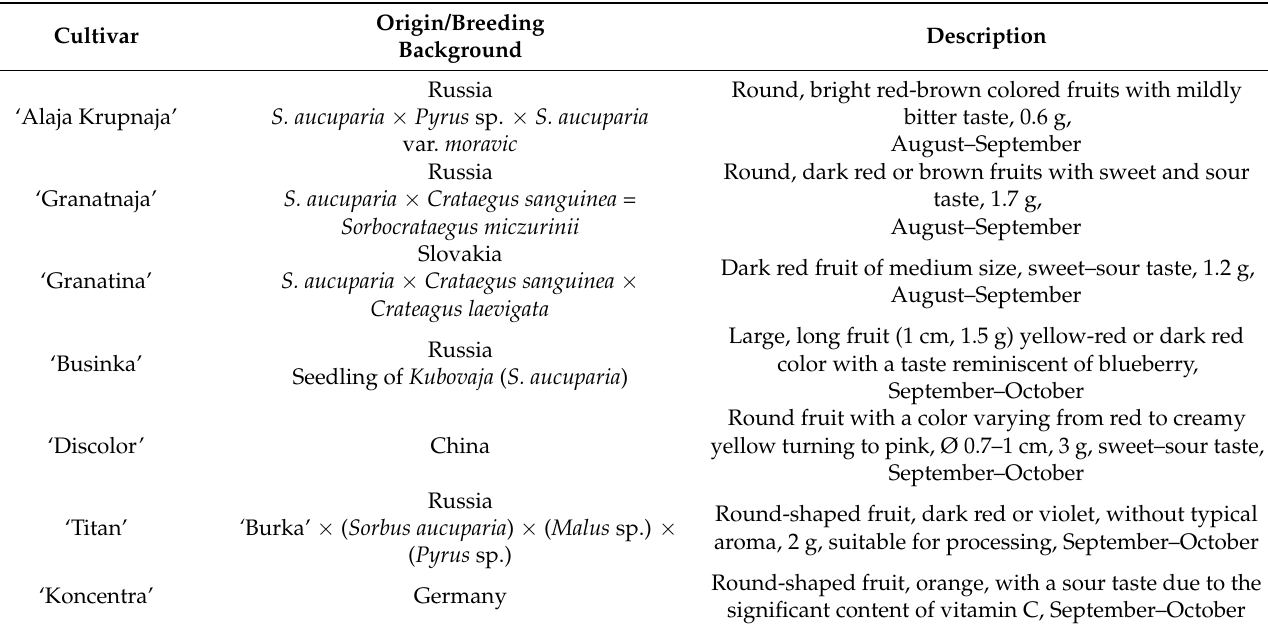
Table 1. Characteristics of the selected Sorbus cultivars.